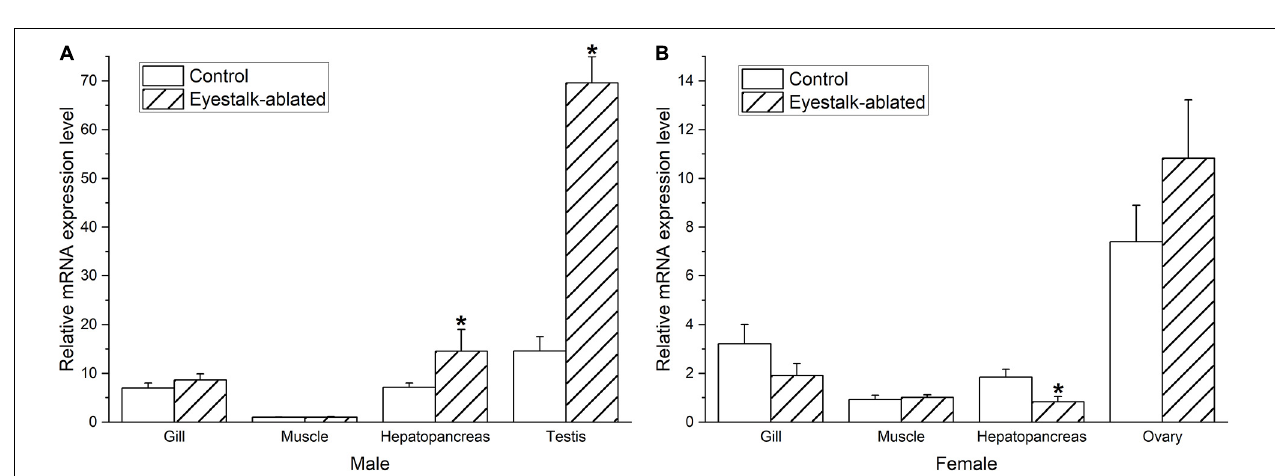
FIGURE 7 | Effect of unilateral eyestalk ablation on Sp-Pol expression in different tissues of male (A) and female (B) S. paramamosain . *Indicates significant expression difference ( P < 0.05). Values are mean ( ±